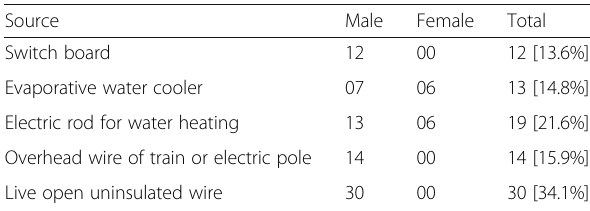
Table 3 Rural versus urban wise distribution of cases